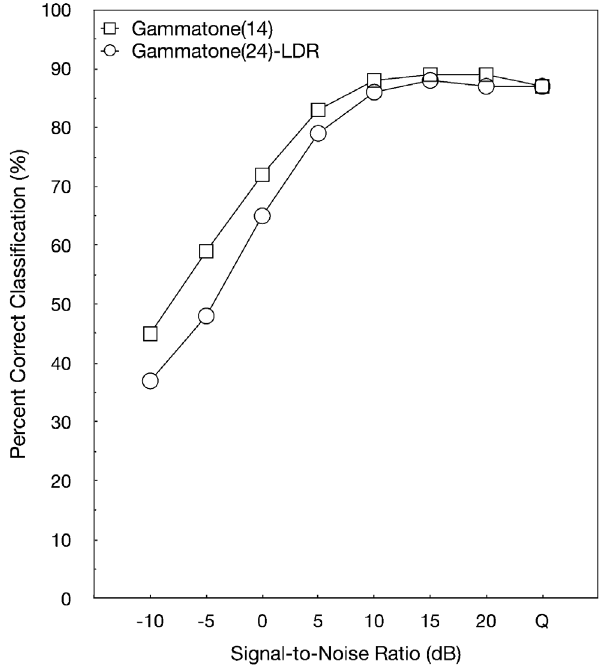
Figure 2. Overall fricative classification accuracy in quiet and at seven SNRs ranging from + 20 to 2 10 dB using Gammatone(14) and Gammatone(24)-LDR.